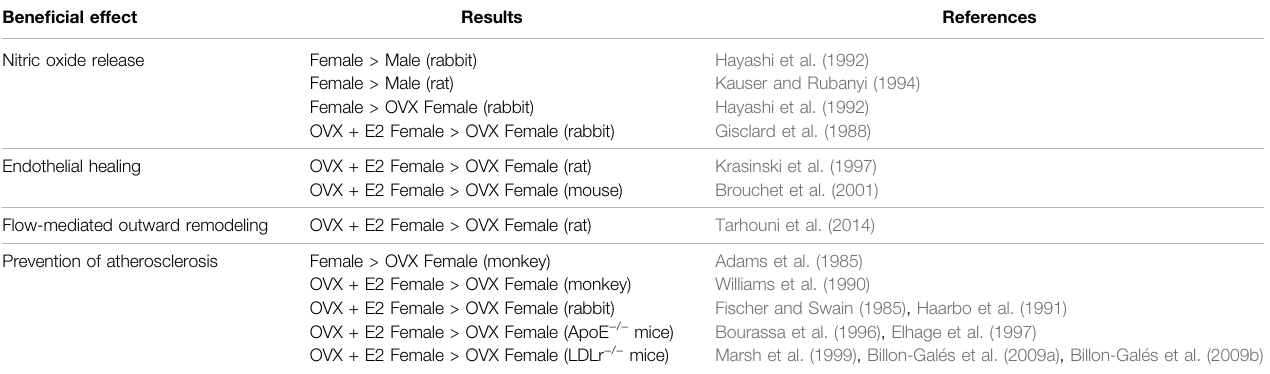
TABLE 2 | Experimental evidence of E2 protection on arteries. OVX, ovariectomized; E2, 17 β